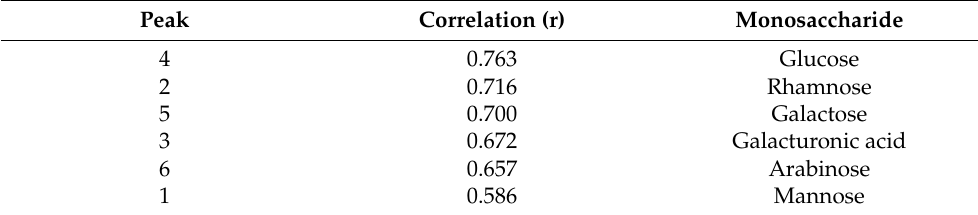
Table 1. Correlation between PMP-HPLC fingerprints and anti-allergic activity of SPs. Peak Correlation (r)